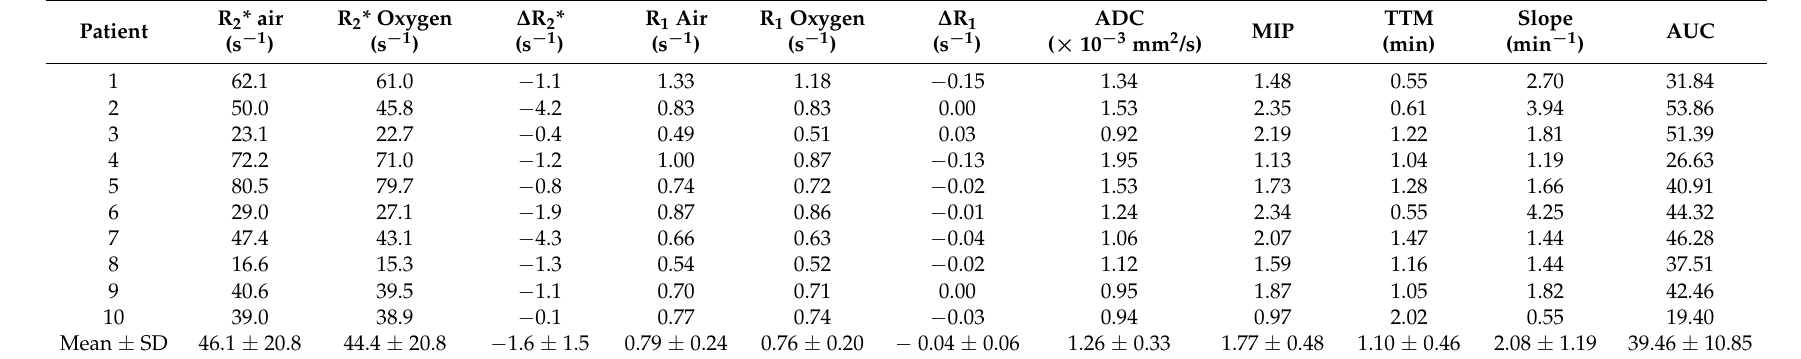
Table 2. Multi-parametric MRI for ten patients (tumor